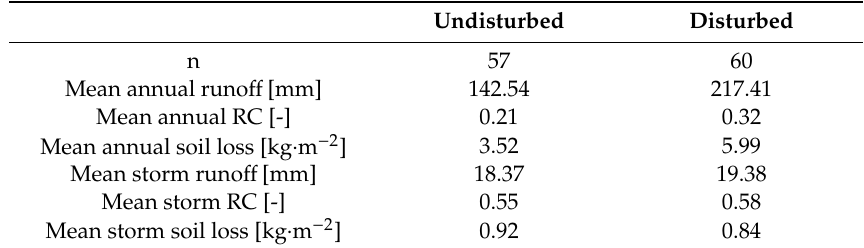
Table 9. Descriptive statistics for standardized modeling results undisturbed and disturbed samples.